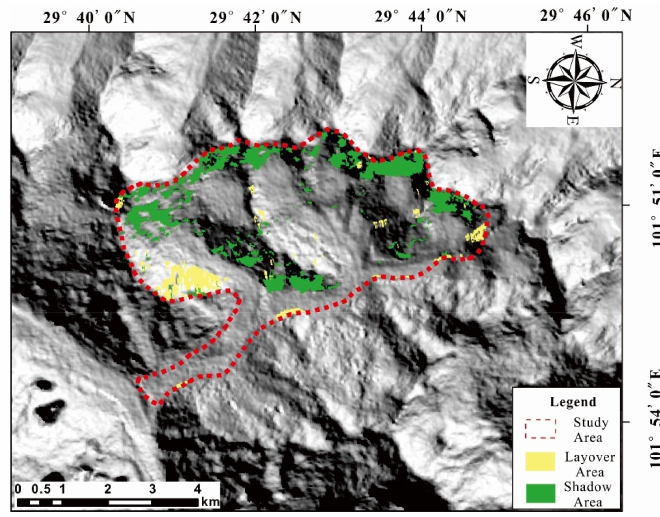
Figure 6. Shadow and layover area of SAR data in this